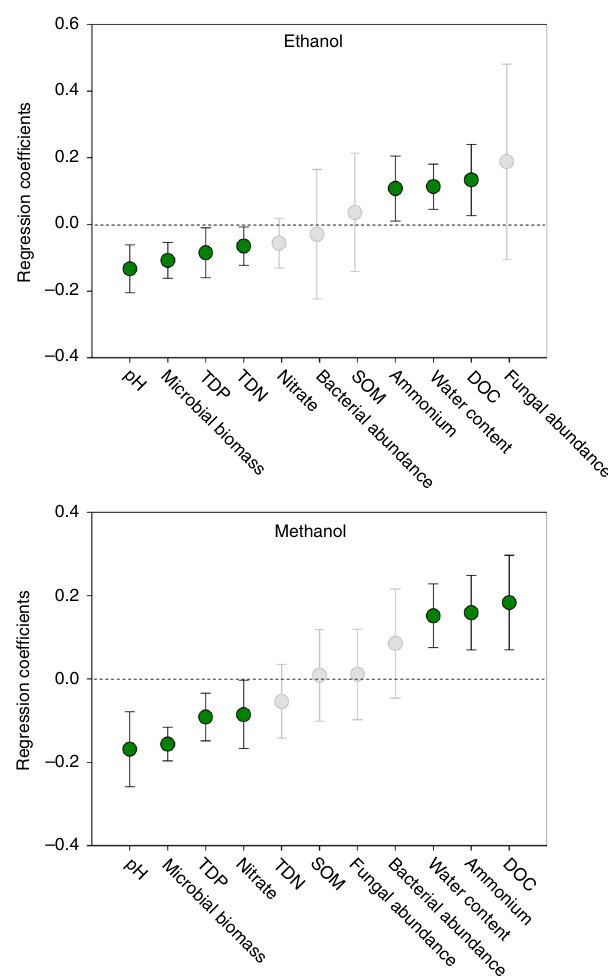
Fig. 2 Correlation between permafrost soil characteristics and BVOC release during permafrost thaw. Regression coef fi cients of partial least squares regression (PLSR) models for the covariance between the measured soil variables and the accumulated release of a ethanol and b methanol during the fi rst 5 h of permafrost thaw. All models had one PLS component. Positive regression coef fi cients indicate a positive relationship and negative ones a negative relationship. Error bars show ± con fi dence intervals (95%) of the regression coef fi cients. Signi fi cant factors are shown in